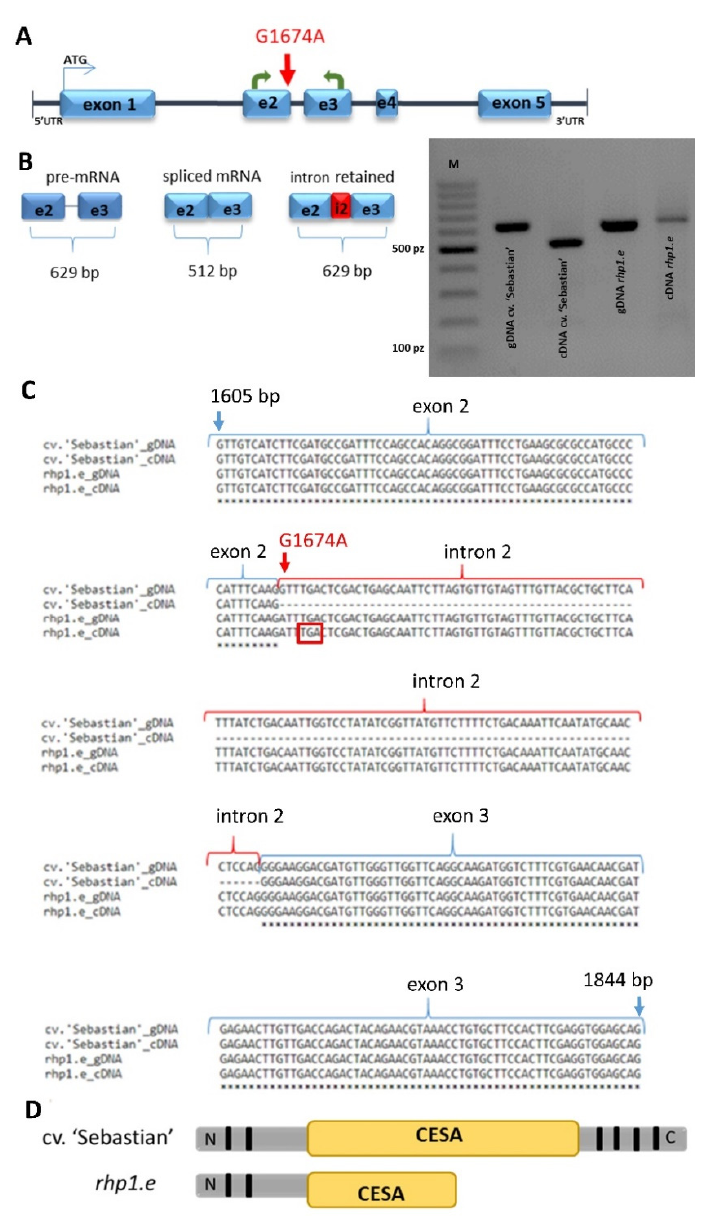
Figure 3. ( A ) The position of identified splice junction mutation in HvCSLC1 gene (red arrow). Green arrows indicate the location of primes used in PCR amplification of a region flanking the mutation. ( B ) PCR products spanning the part of exons 2 and 3 of HvCSLC1 sequence that were amplified using genomic DNA (gDNA) and cDNA as templates in cv. ‘Sebastian’ and rhp1.e mutant. ( C ) The alignment of a part of the HvCSLC1 genomic (1605 bp to 1844 bp) and cDNA sequences representing fragment of exon 2, intron 2 and fragment of exon 3 of cv. ‘Sebastian’ and rhp1.e mutant. Red arrow indicates a splice junction mutation at the donor splicing site, red frame shows the premature STOP codon in the rhp1.e cDNA sequence. ( D ) The scheme represents the full length HvCSLC1 protein in the WT and the shorter protein with the lost part of amino acid sequence as a result of mutation in the rhp1.e mutant. Black boxes indicate location of transmembrane domains (TDMs); CESA—cellulose synthase domain.